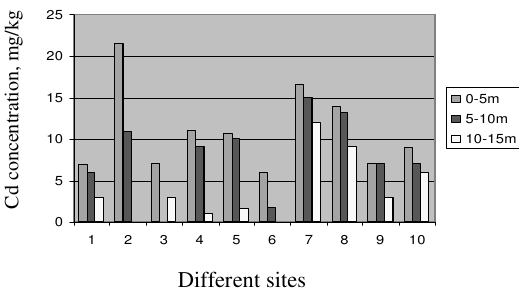
Figure 3. Cd (mg/kg) in roadside agricultural